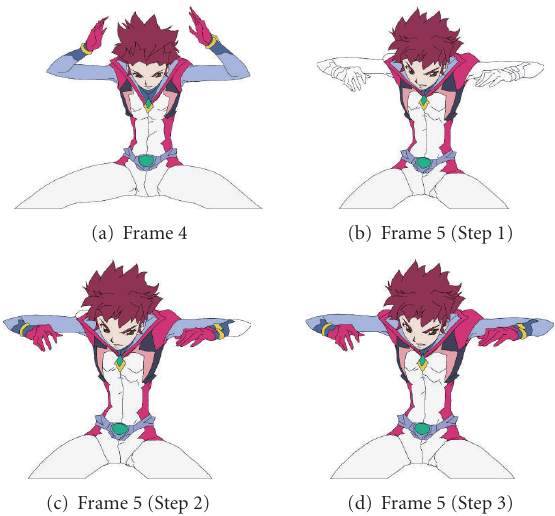
Figure 8: Auto coloring